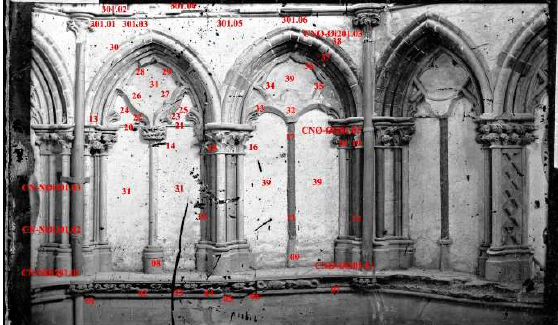
Figure 8. Condition of the North-East bay and half of the East bay before the restoration (NDR Archive: Nr. 186), with the referenced changes and restorations occurred.